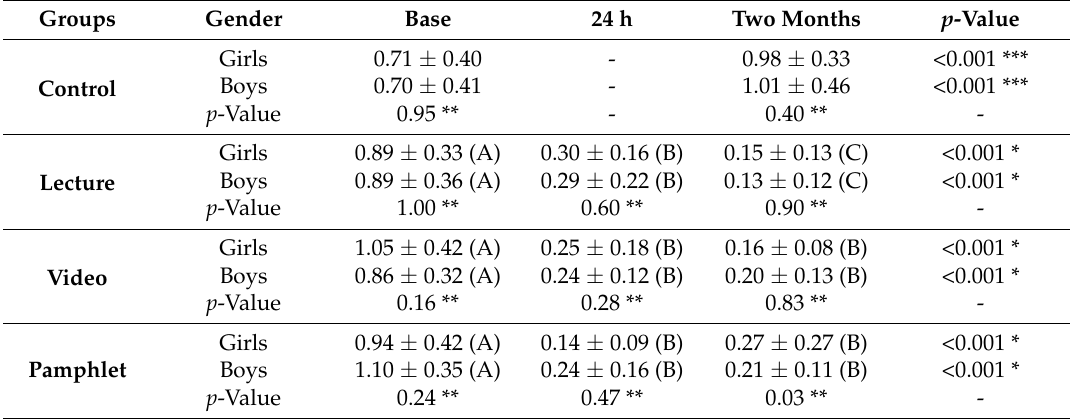
Table 3. Comparison of PI in different groups by